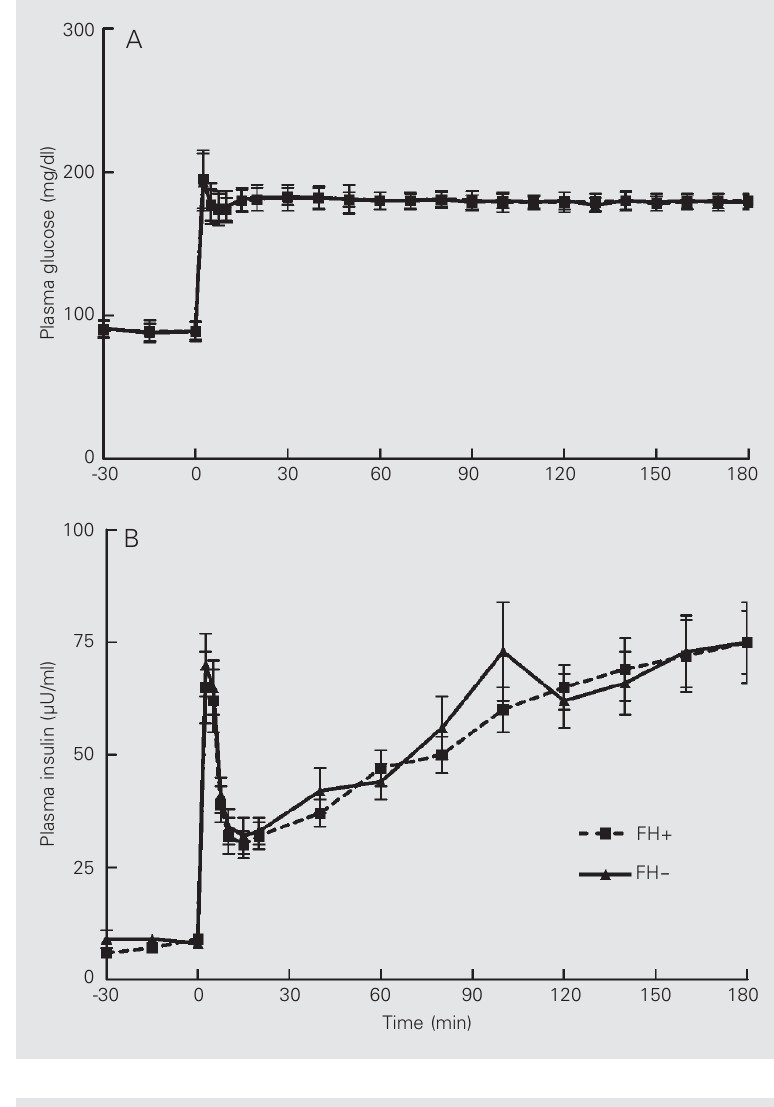
Figure 2. Plasma glucose (A) and plasma insulin (B) concentrations during hyperglycemic clamp experi- ments. FH+ and FH- indicate individuals with and with- out first-degree relatives with type 2 diabetes, respec- tively. Data are reported as means ± SEM for 48 indi- viduals in each group.